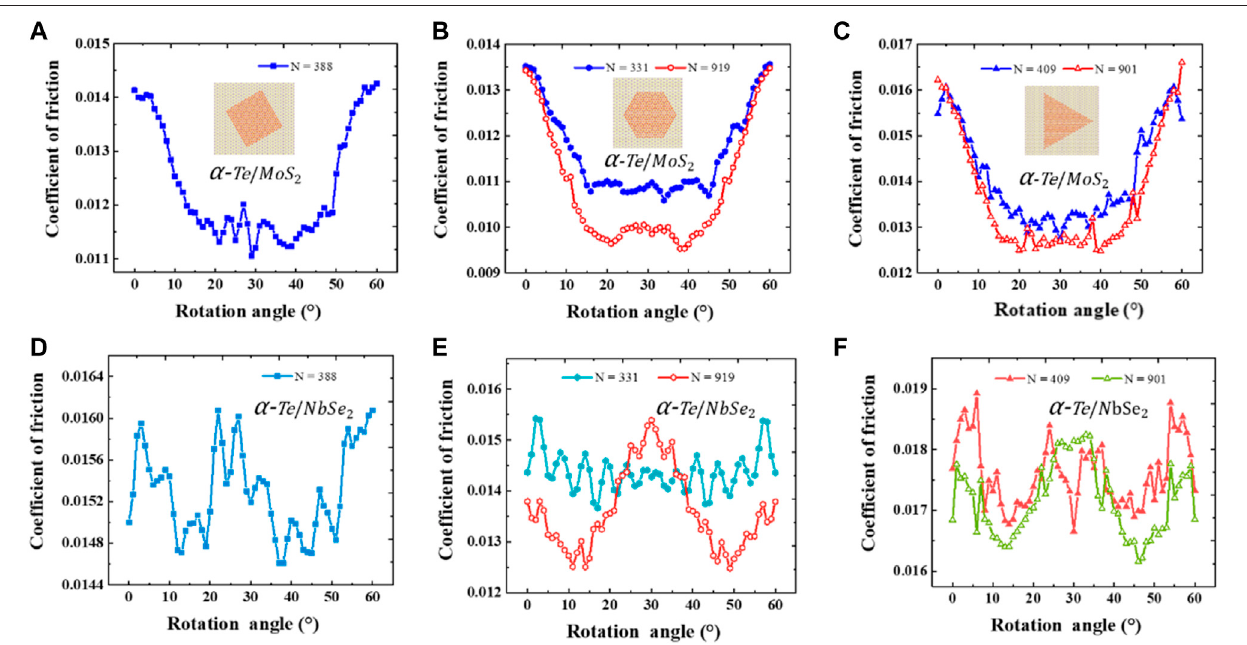
FIGURE 5 | Variation in the interlayer friction coef fi cient with rotation angle for van der Waals heterostructures of different shapes. (A – C) α -Te/MoS 2 ; (D – F) α -Te/ NbSe 2 . The slider shapes in (D – F) are rectangular, triangular and hexagonal, respectively.